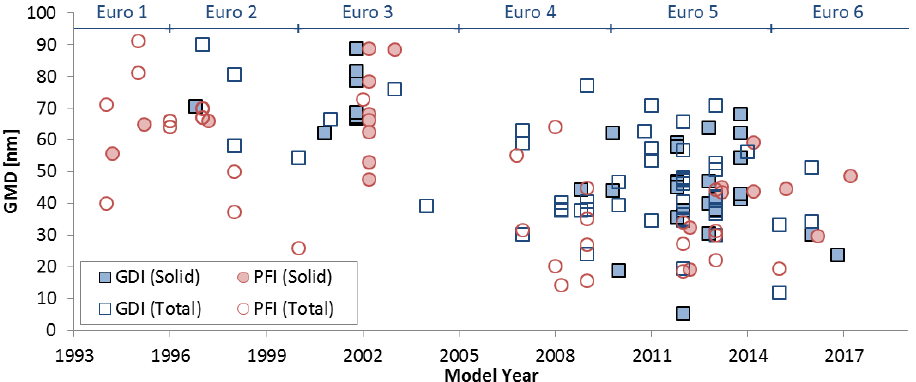
Figure 3. Geometric mean diameter (GMD) of solid and total (solid + volatiles) size distributions for gasoline direct injection (GDI) and port fuel injection (PFI) vehicles. Results from all regions (EU, US, and Asia).